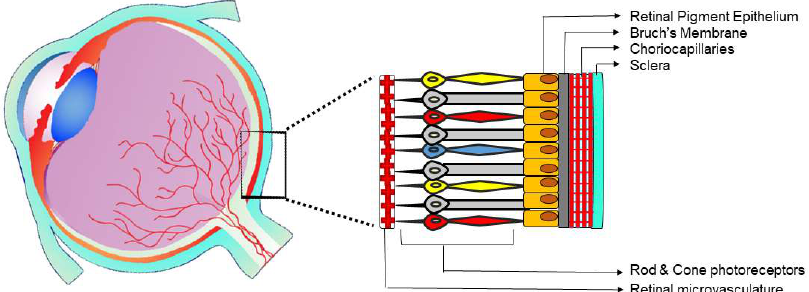
Figure 1. Schematic representation of the two microvascular beds in the posterior eye segment. The light-sensing tissue of the eye, retina, is irrigated by the retinal microvasculature. The choriocapillaries are located in the choroid, between the sclera and Bruch’s membrane, and supply the outer retina. As example, choriocapillaries are the vessels affected in neovascular age-related macular degeneration (nAMD), while the retinal microvasculature is responsible for the pathologic angiogenesis of proliferative diabetic retinopathy (PDR).